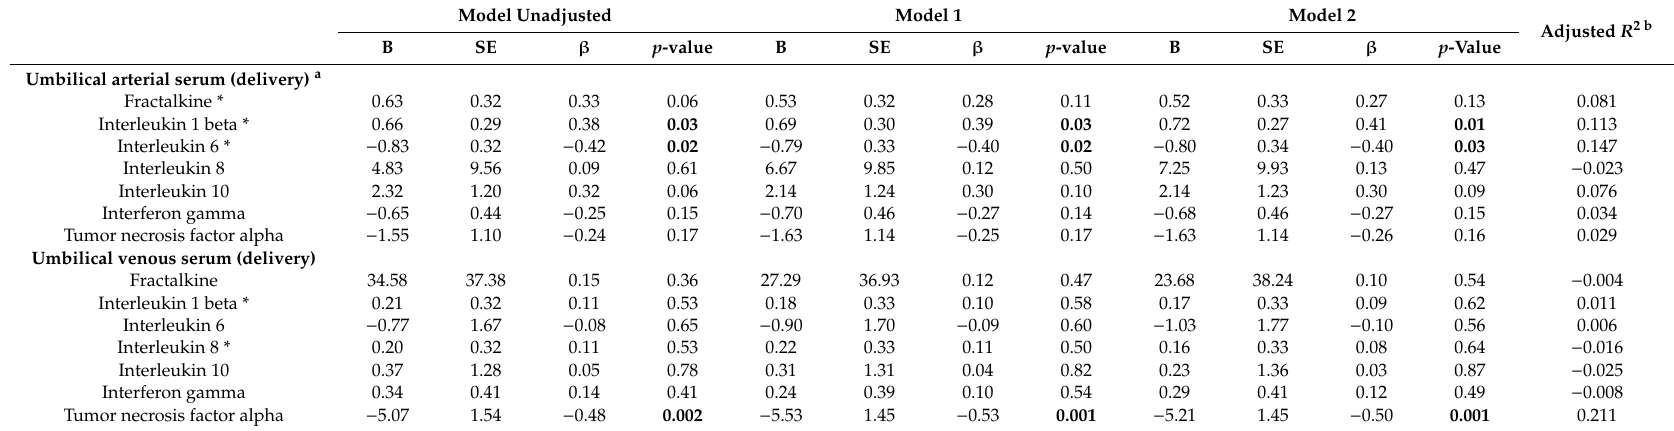
Table 4. Per-protocol analyses showing the e ff ect of the concurrent exercise-training program on arterial and venous cord serum cytokines at delivery ( n =